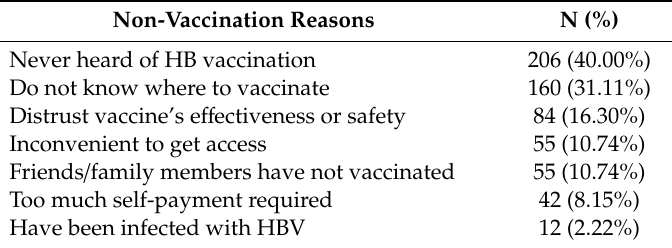
Table 3. The reasons for non-vaccination (N = 516).